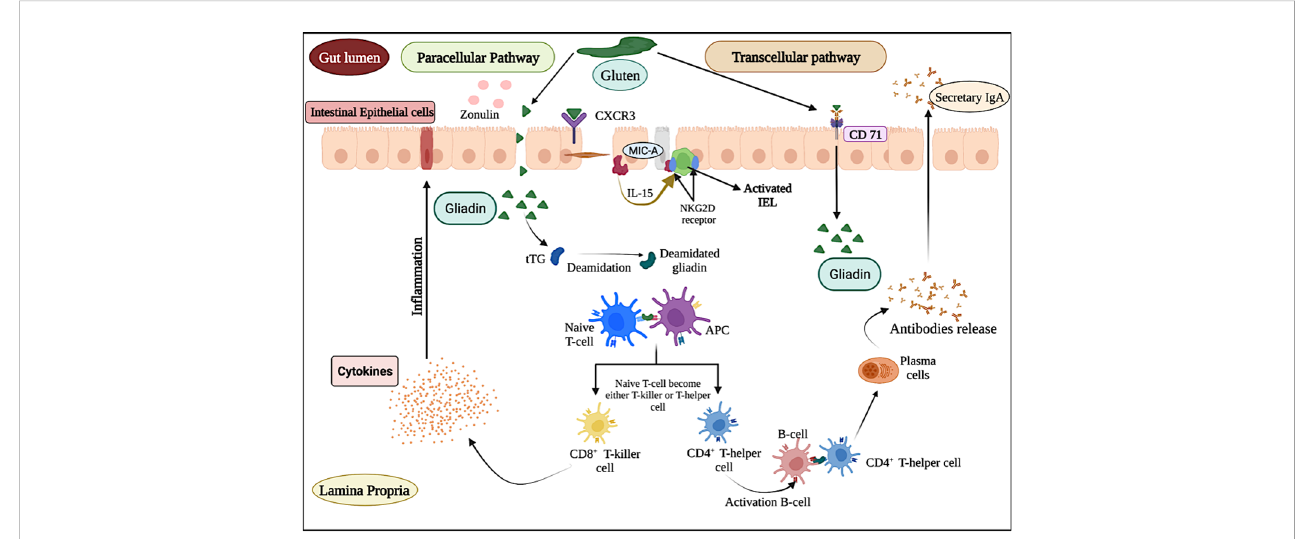
FIGURE 1 Schematic representation of celiac disease pathogenesis and immune